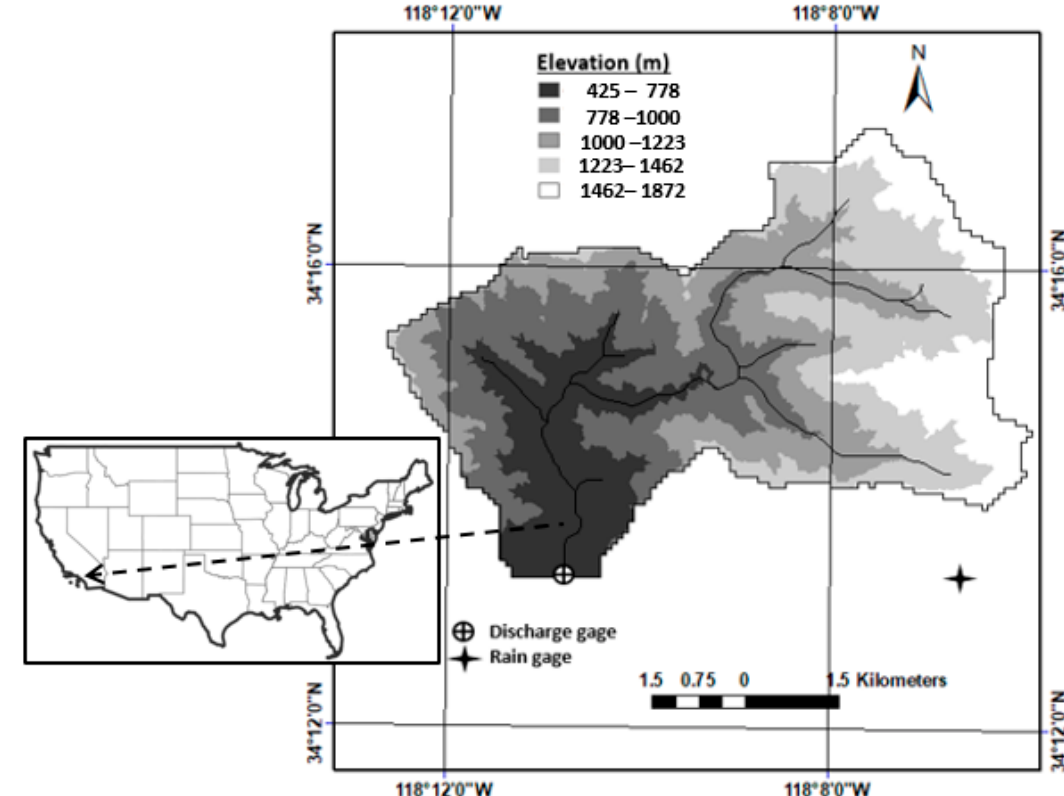
Figure 1. The study watershed, Upper Arroyo Seco watershed in southern California, USA. In August 2009, the ‘Station Fire’ started in the Angeles National Forest. The fire moved into the Arroyo Seco area overnight engulfing most of the watershed, 95%, in this study as shown in Figure 2. The burned severity map in Figure 2 was obtained from